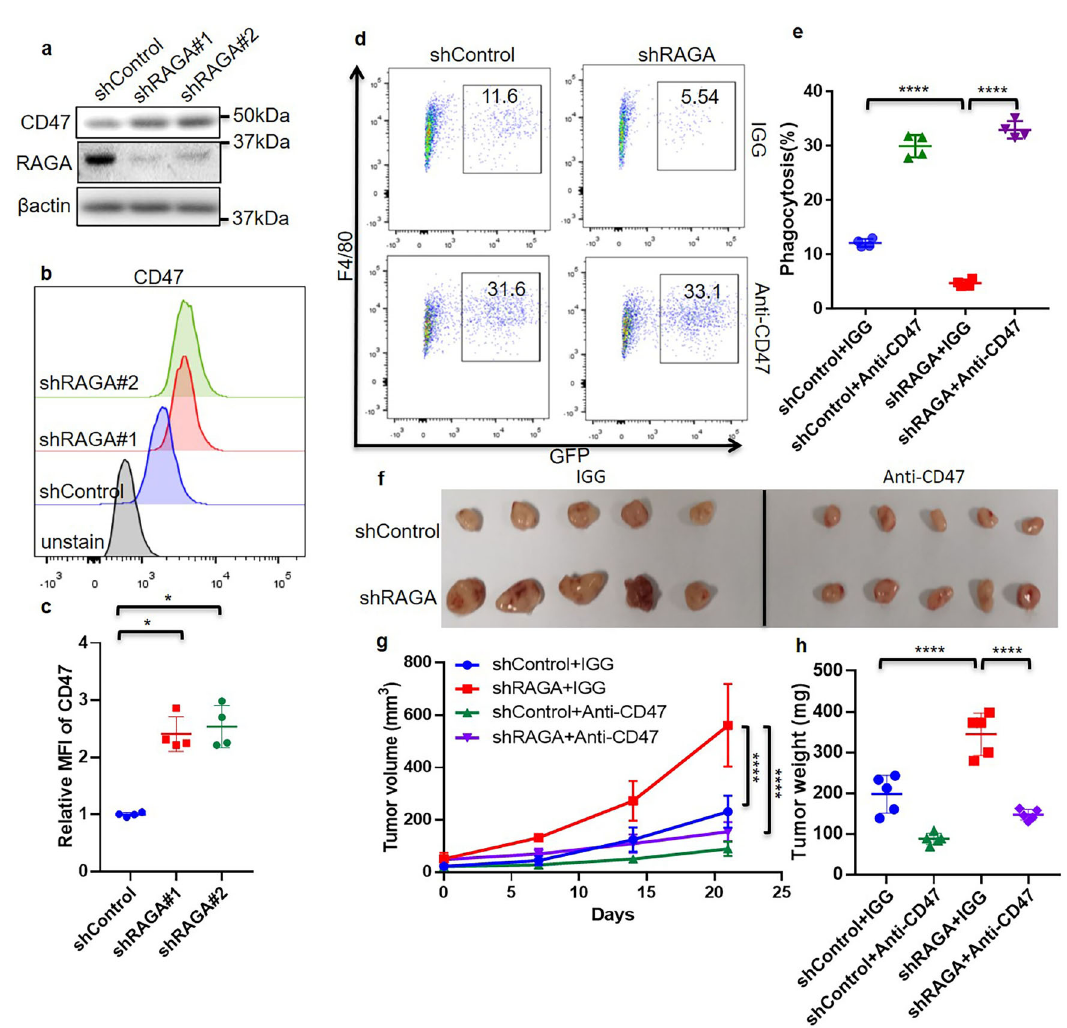
Fig. 2 RAGA depletion suppresses phagocytosis and promotes tumor growth via CD47 accumulation. a Immunoblot analysis of indicated proteins in control and RAGA knockdown A549 cells. b Representative fl ow cytometry of CD47 protein expression on the cell surface. c Statistical analysis of cell surface CD47 expression ( n = 4 per group). d Representative fl ow cytometry analysis of in vitro phagocytosis in macrophage and GFP-labeled A549 coculture system. Numbers in the outlined areas indicate the percentage of macrophages with phagocytosis. e Statistical analysis of the percentage of phagocytic macrophages cocultured with control and RAGA knockdown A549 cells under IGG or anti-CD47 antibody treatment ( n = 4 per group). f The tumor xenografts of control and RAGA knockdown A549 with IGG or anti-CD47 antibody treatment. g The growth curve of A549 tumor xenografts is shown in ( f ) ( n = 5 per group). h The weight of A549 tumor xenografts is shown in ( f ) ( n = 5 per group). Data were from two or three